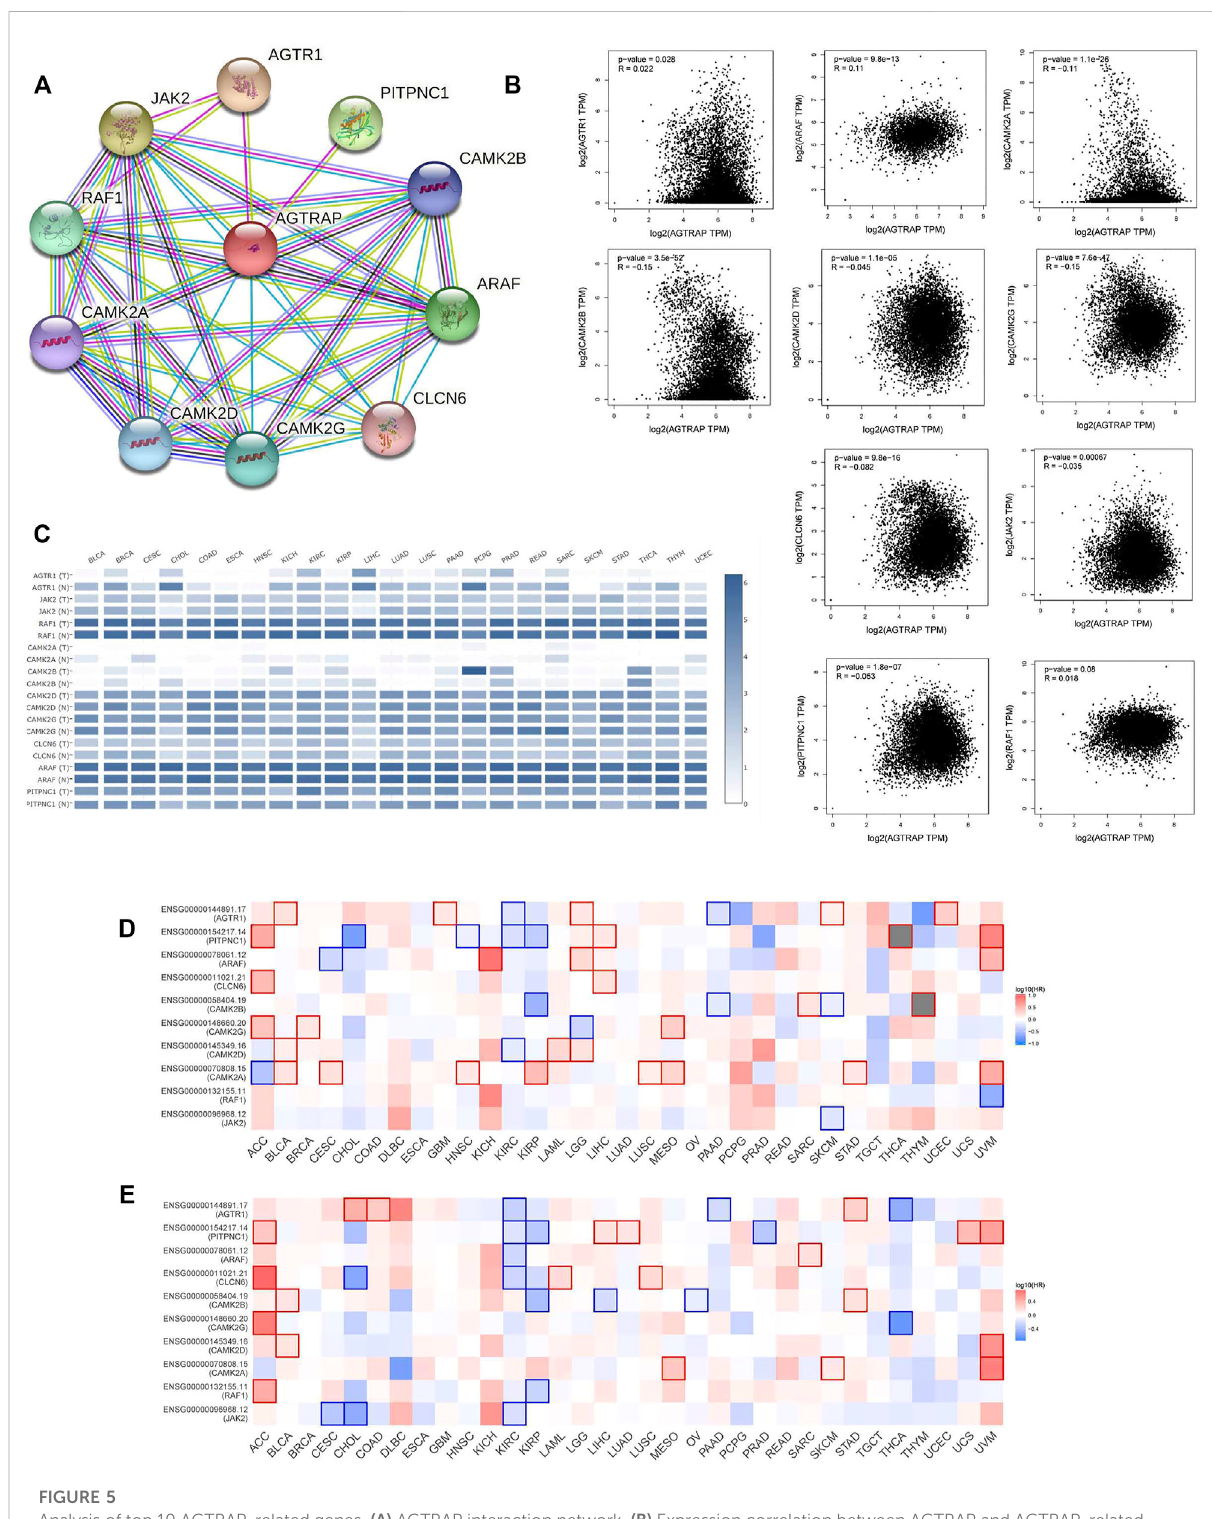
FIGURE 5 Analysis of top 10 AGTRAP-related genes. (A) AGTRAP interaction network. (B) Expression correlation between AGTRAP and AGTRAP-related genes (AGTR1, JAK2, RAF1, CAMK2A, CAMK2B, CAMK2D, CAMK2G, CLCN6, ARAF, and PITPNC1). (C) Expression of AGTRAP-related genes in differentcancersamplesandnormaltissues. (D) Overallsurvival(OS)analysisofAGTRAP-relatedgenesinpan-cancer. (E) Disease-freesurvival(DFS) analysis of AGTRAP-related genes in